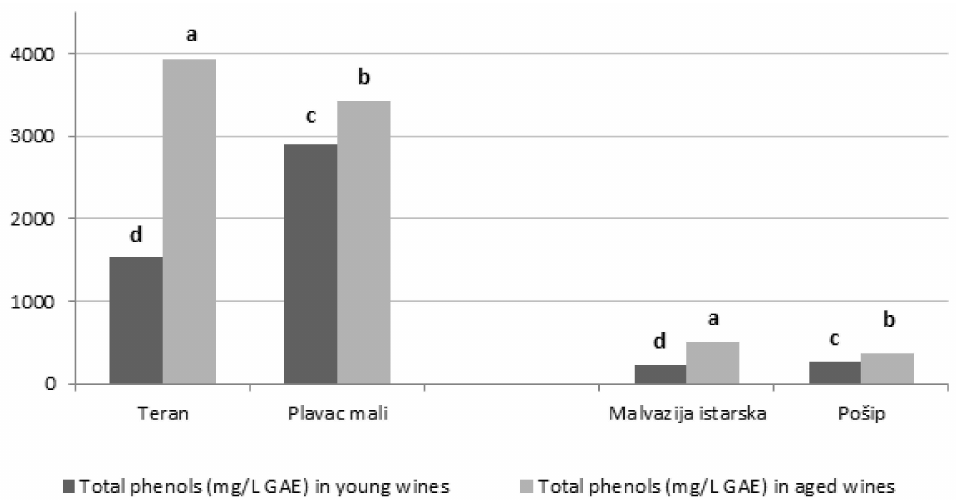
Figure 1. Total phenolic content (TPC) of young and aged Croatian wines; red—Teran and Plavac mali, and white—Malvazija istarska and Pošip: young white wines produced without maceration, young red wines produced with standard 7–8 days maceration, aged wines produced with maceration of 7 days (white wines) and prolonged 15–30 days (red wines) followed by maturation in oak barrels. Each value represents the mean ± standard deviation; different lowercase letters represent statistically significant differences between wine samples at p < 0.05 obtained by one-way ANOVA and least significant difference (LSD)